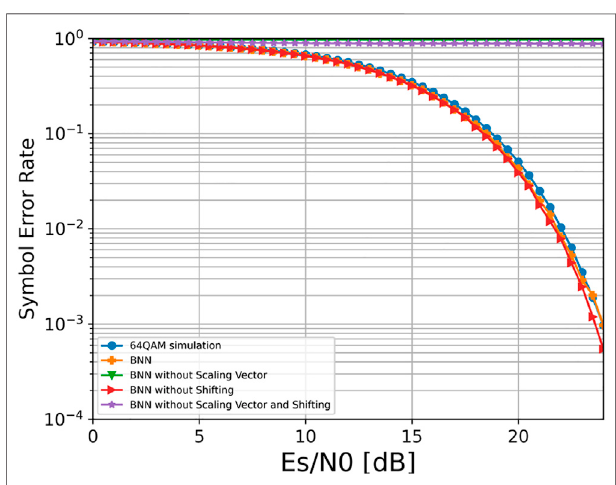
FIGURE 10 | Performance comparison of different BNN